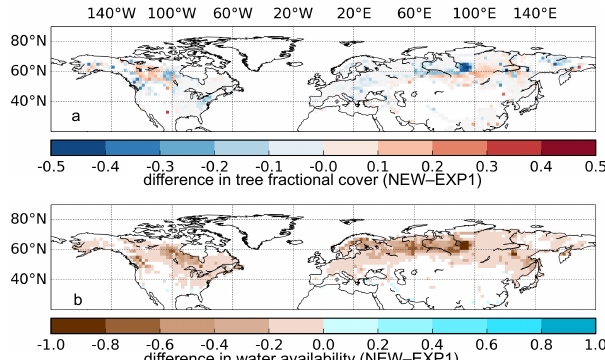
Figure 12. Difference of tree fractional cover (a) and water avail- ability (WA) (b) between with and without soil freezing (NEW– EXP1). WA is averaged over the growing season (May–September) and over tree PFTs (PFTs 2–9) weighted by their fractions.